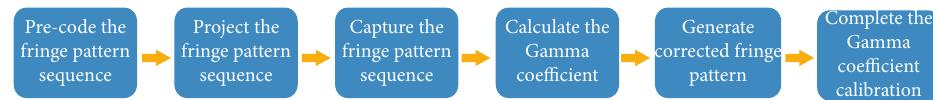
Figure 2: The flowchart of the proposed calibration algorithm of the gamma coefficient.